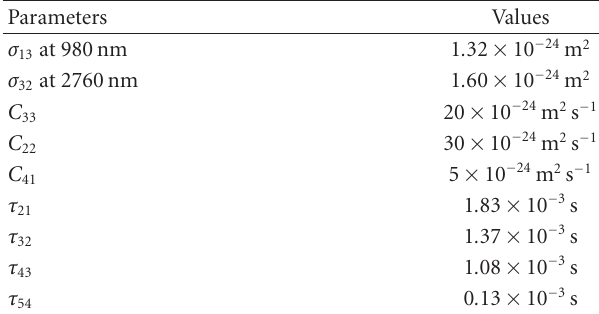
Table 1: Spectroscopic parameters of Er 3+ -doped Ga 5 Ge 20 Sb 10 S 65 chalcogenide